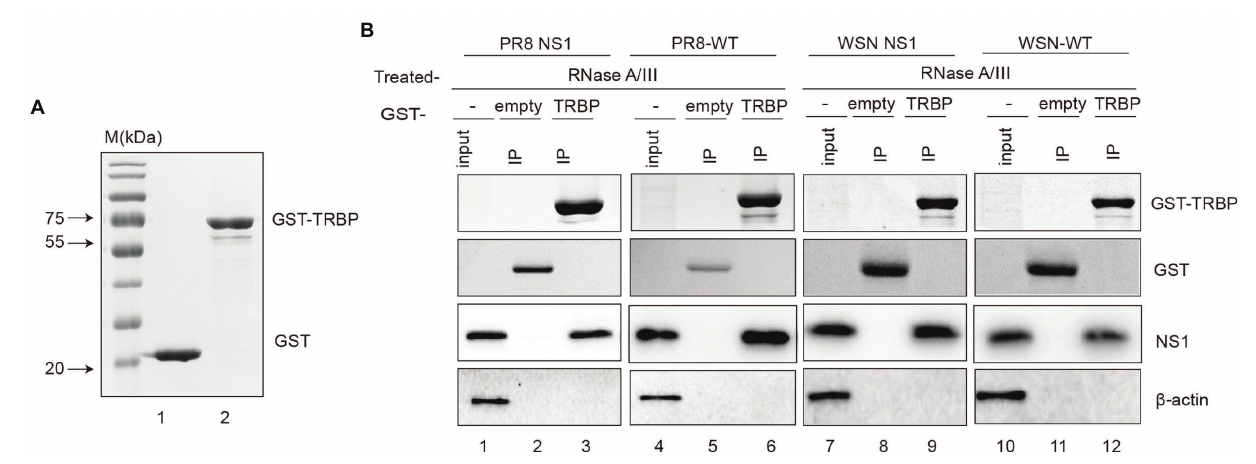
FIGURE 2 | GST pull-down assays of NS1 and TRBP. (A) Purification of GST and GST-TRBP proteins. (B) GST pull-down assay showing the interaction between NS1 and TRBP. Lysates of 293 T cells transfected with PR8 NS1 or WSN NS1 or infected with PR8-WT (MOI = 1) or WSN-WT (MOI = 1) were incubated with an equal amount of GST or GST-TRBP bound to glutathione-sepharose 4B beads with RNase A (10 mg/ml) and RNase III (5 U/ml) treatment. Samples were analyzed by SDS–PAGE with the indicated